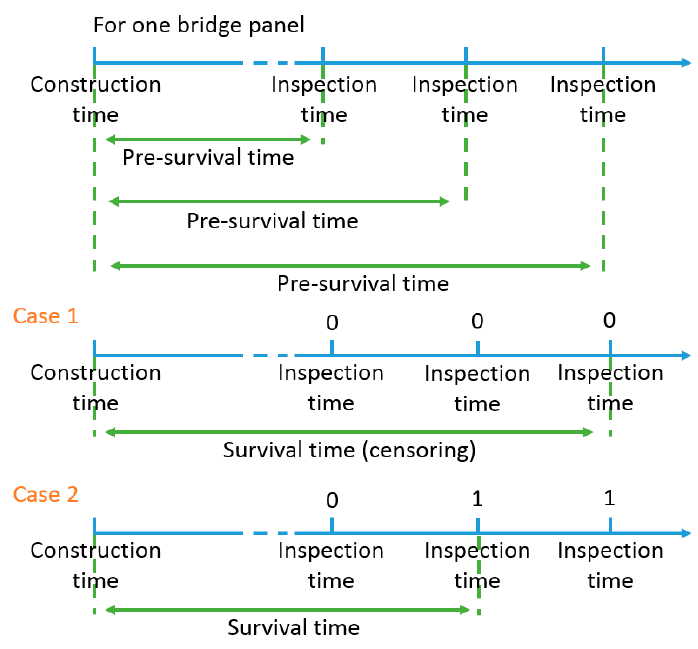
Figure 5. Calculation of survival time.